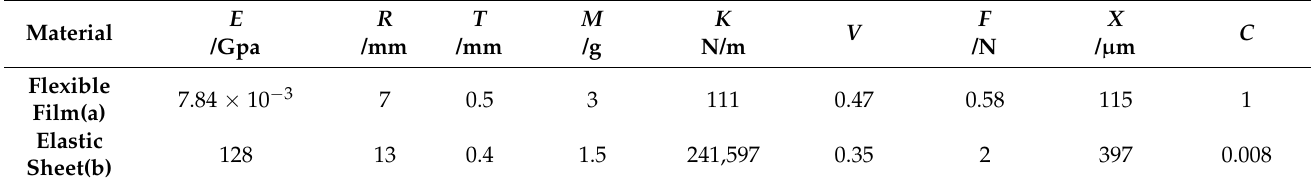
Table 1. Structural parameters of flexible film and elastic sheet.